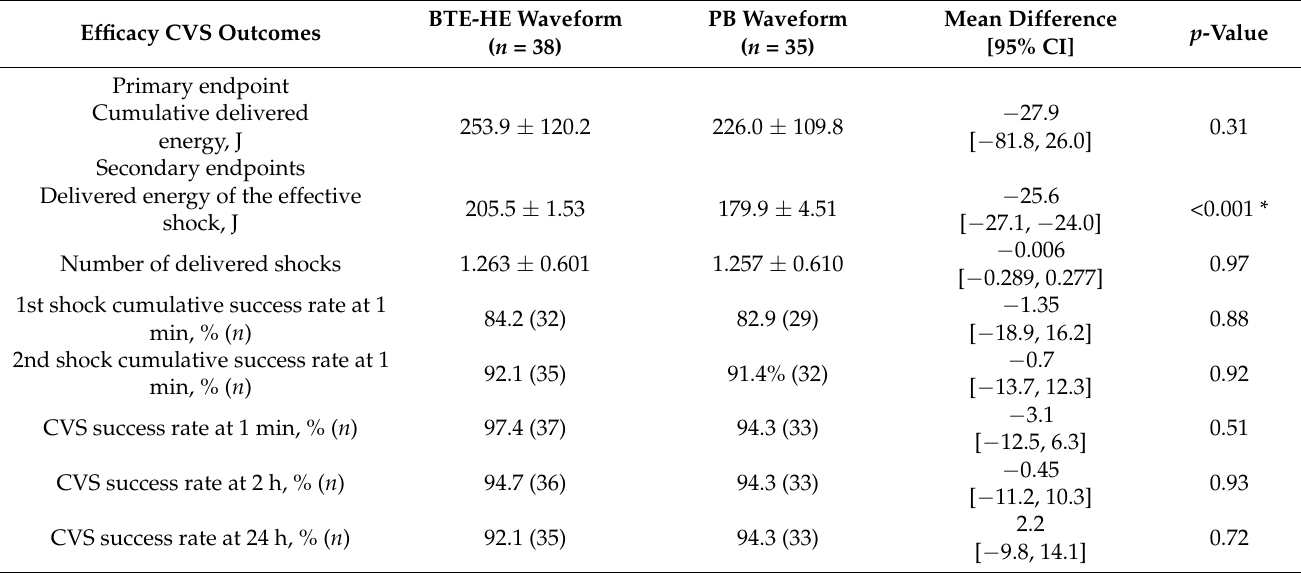
Table 2. Efficacy CVS outcomes. Data are expressed as mean value ± standard deviation for continuous variables, and % (number) for categorical variables. Estimates are reported as mean difference [95%